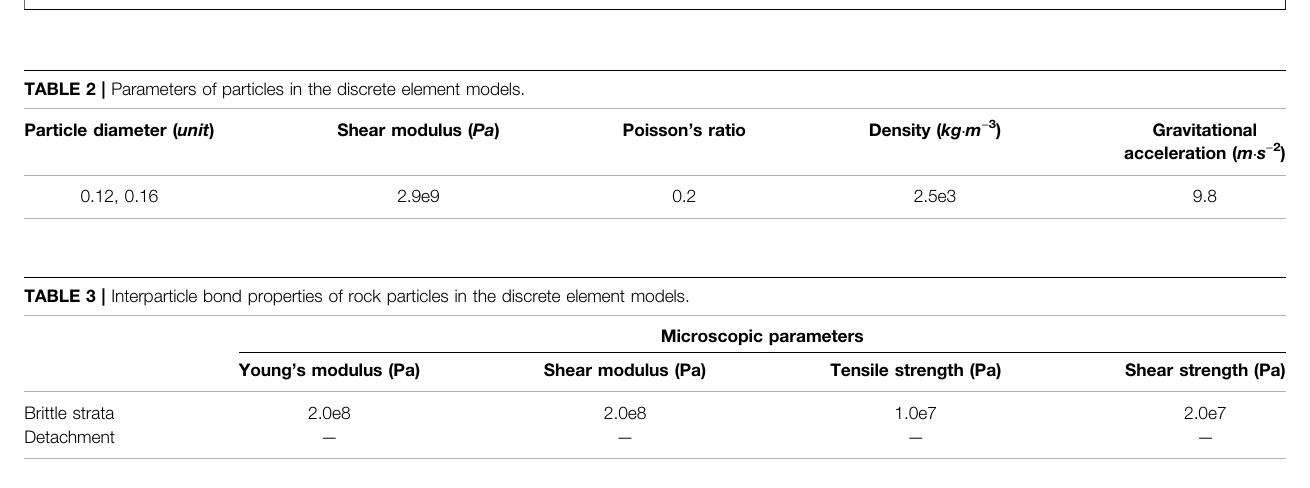
FIGURE 5 | Initial set-up of the DEM models. Brittle strata are shown as black and yellow layers, detachment stratum is shown in red, and plate walls are shown in purple.